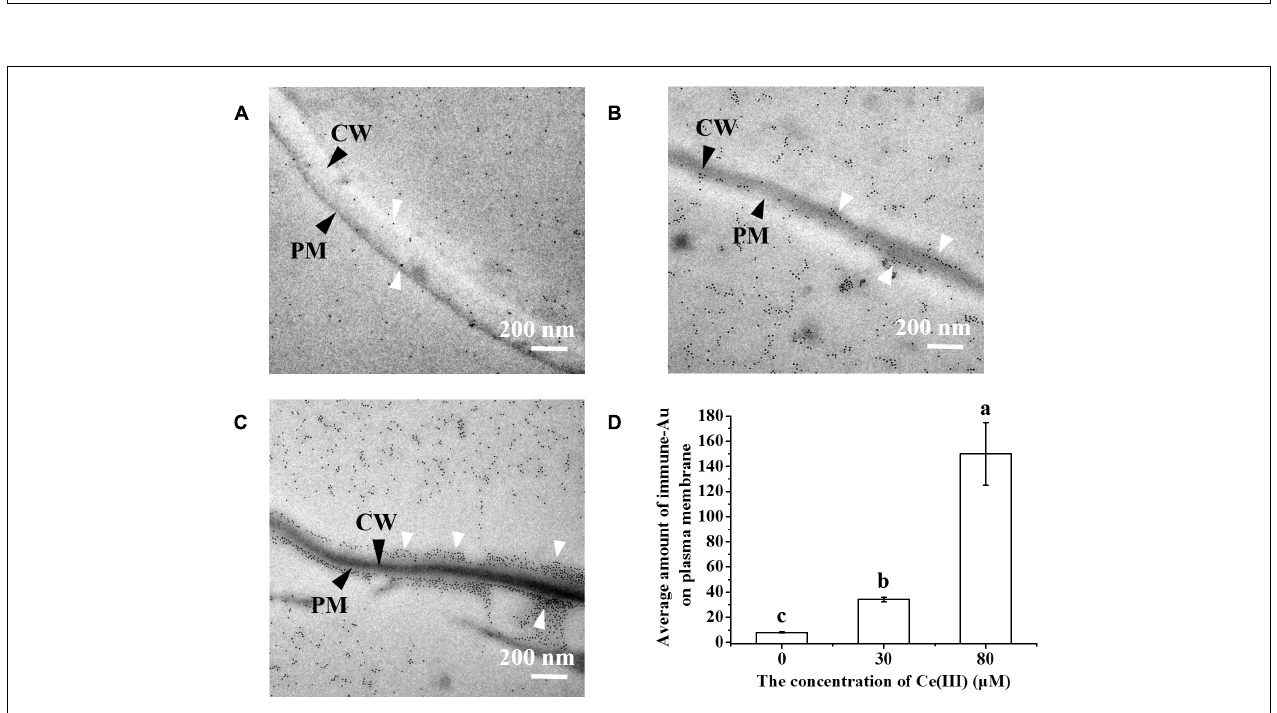
FIGURE 3 | The TEM images of the immune-Au labeled AGP in Arabidopsis leaf cells in the presence of Ce(III) at 0 (A) , 30 (B) , 80 µ M (C) and the average amount of immune-Au particles in a leaf cell after Ce(III) treatments the different letter on the column means the values of the column are not significantly different at p < 0.05 (D) . The observation was carried out 12 h after the treatments. Immune-Au labeled AGP were pointed by white arrows. CW, cell wall; PM, plasma membrane.